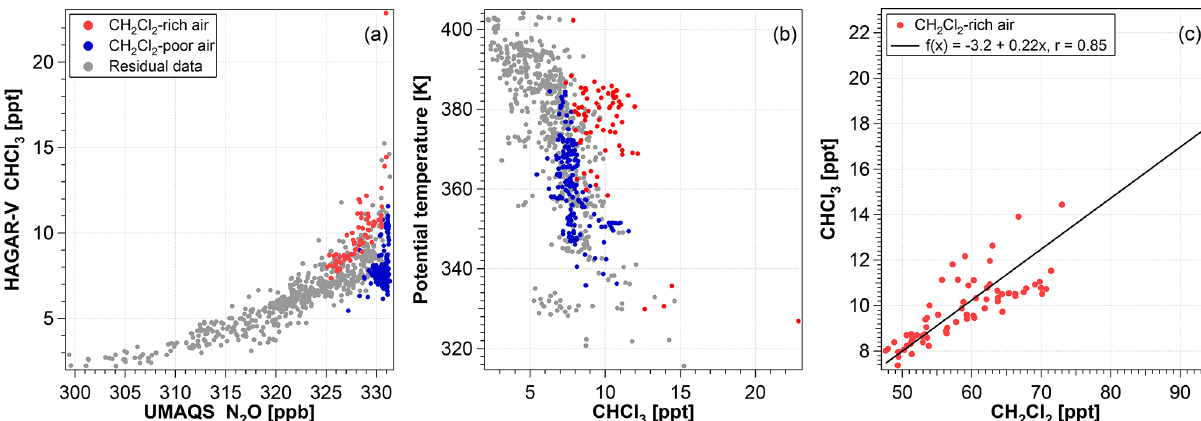
Figure 12. CHCl 3 –N 2 O relationship (a) and CHCl 3 as a function of potential temperature (b) color coded to highlight measurements of